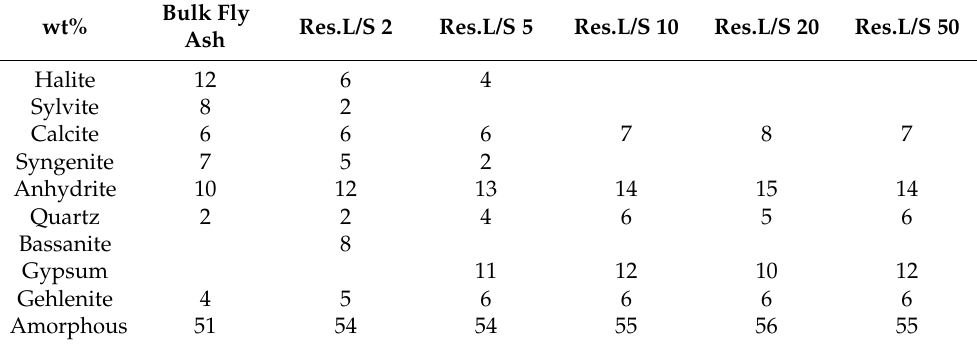
Table 1. Mineralogical composition (wt%) of fly ash: fly ash before washing test and fly ash residual solid (Res) after washing test at different L/S. Crystalline phase content is estimated with an error of 1% wt, while amorphous fraction content is estimated with an error of 5%